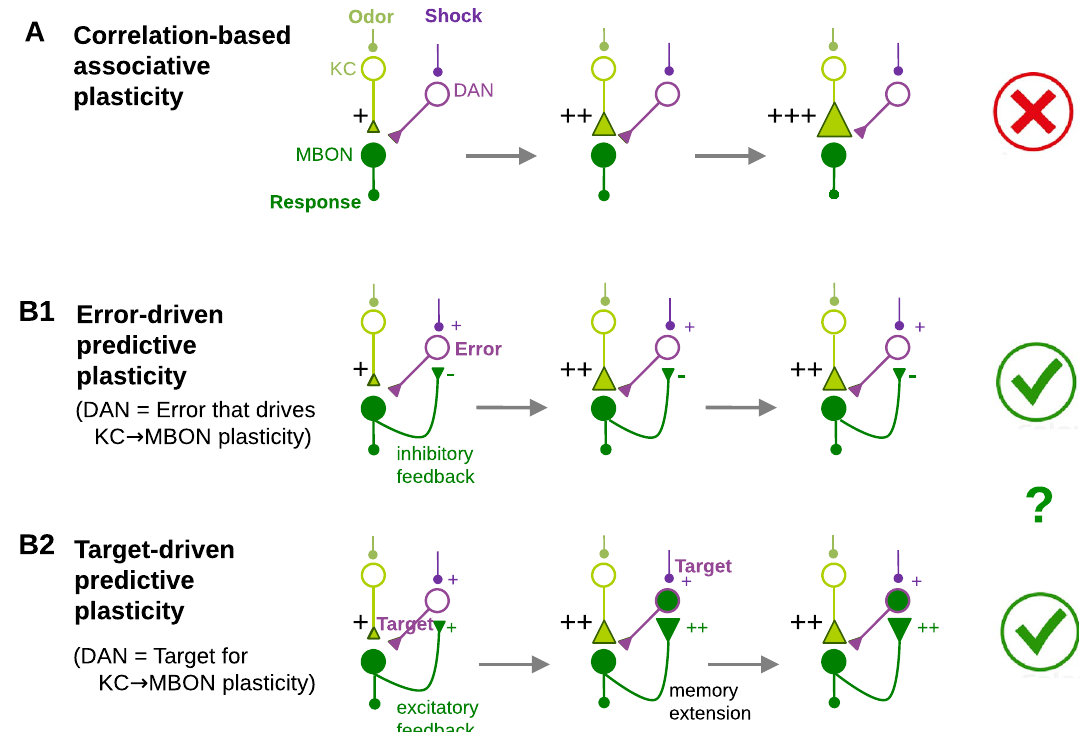
Figure 1. Associative versus error- or target-driven predictive plasticity. (A) Pairing of an odor (CS) with a shock (US) is typically thought to induce correlation-based synaptic strengthening of the synapses mediating the conditioned response, here from the Kenyon cells (KCs) to the mushroom body output neurons (MBONs). Repeated pairing always leads to a stronger association strength. (B) In predictive coding, plasticity